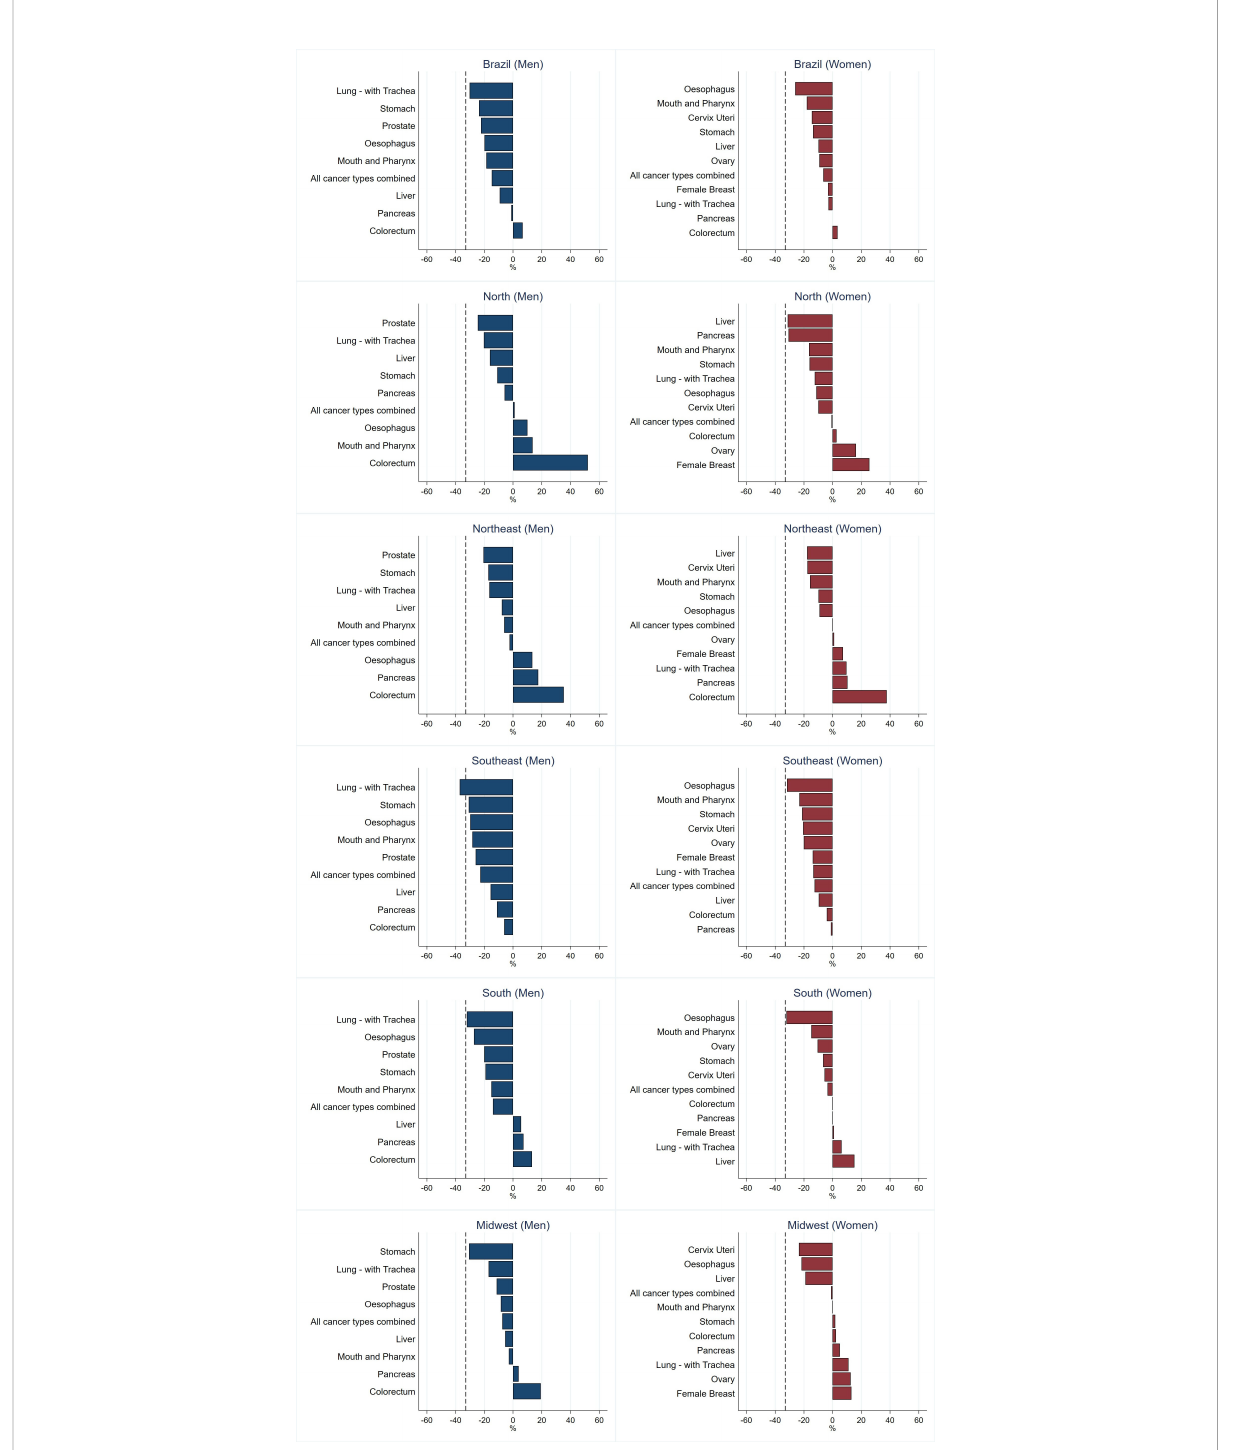
FIGURE 3 Probability of death in the last predicted period (2026 – 2030) compared to the last observed period (2011-2015) in relation to the 33% reduction target 3.4 (shown as a dashed black